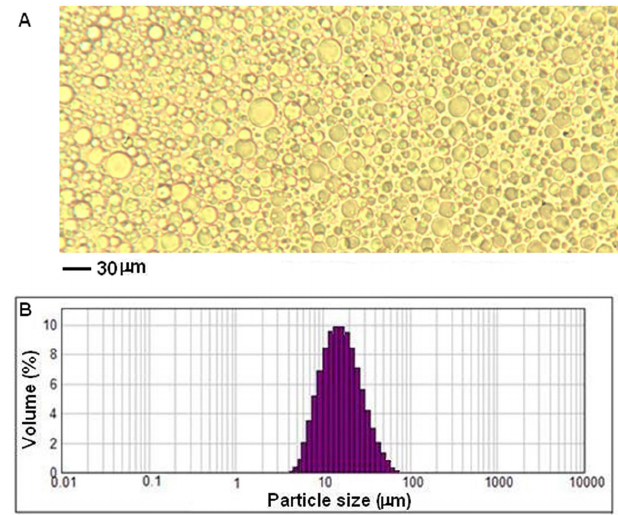
FIGURE 5 - Image of the cream obtained by optical microscopy (A) and droplet size distribution profile